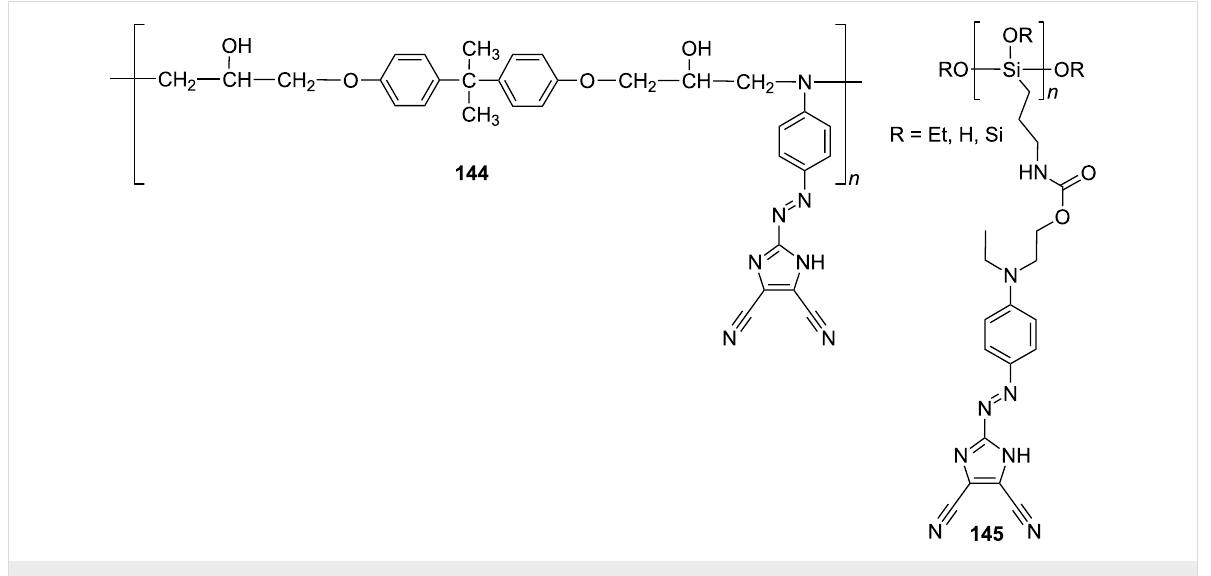
Figure 23: Epoxy- and silica-based polymers functionalized with 4,5-dicyanoimidazole unit [105,130].